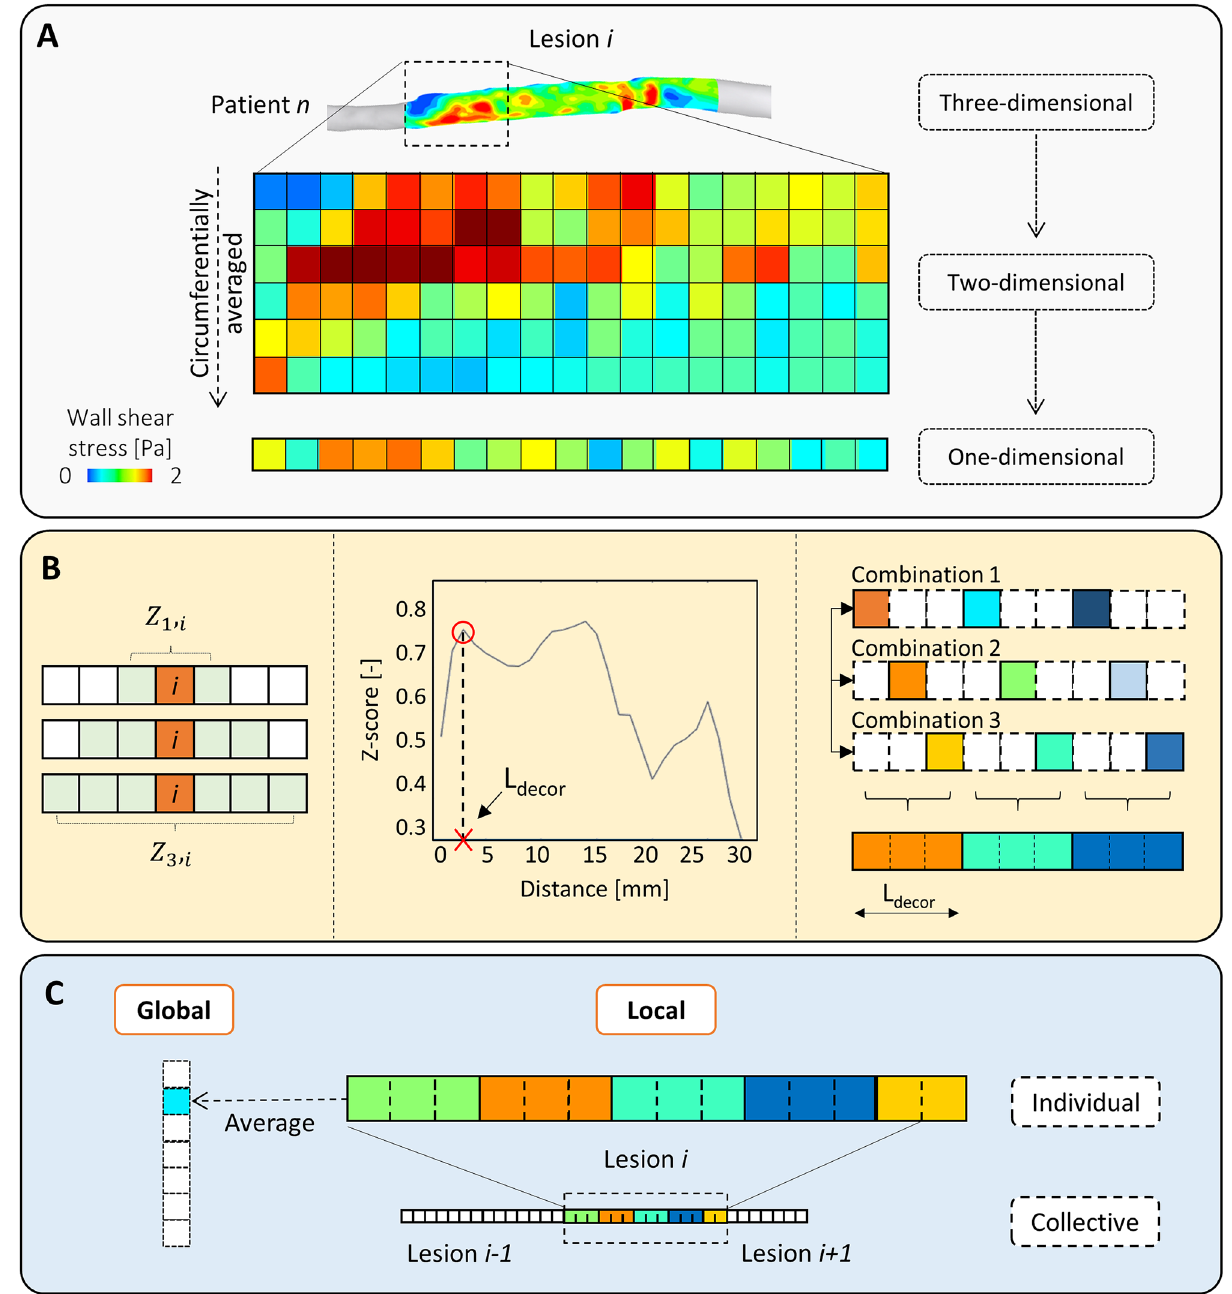
Figure 3. ( A ) Output of the computational fluid dynamics analysis: from the three-dimensional distribution of the wall shear stress (WSS) based variable to the one-dimensional map presenting values averaged along the circumferential direction. ( B ) Explanation of the z-score analysis: representation of the involved cells, choice of the decorrelation length and creation of the combinations with the output one-dimensional map used for the statistical analyses. In this example, the decorrelation length is 3. ( C ) Levels of investigation: (i) ‘global’, in which an averaged value is extracted from the decorrelated map of each lesion and collected with the others; (ii) ‘local’, divided into ‘individual’, in which the single lesion is considered, and ‘collective’, in which all the single lesions are collected into a unique decorrelated